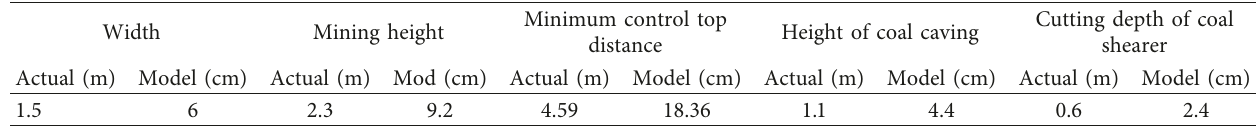
Figure 11: Overview of the experimental model of complex structure coal seam. Table 5: Hydraulic support dimensions.